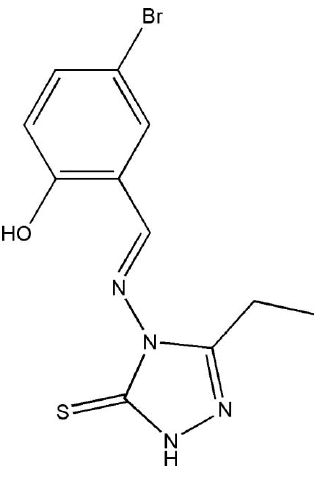
H BrN OS, crystallized as a racemic 11 11 4